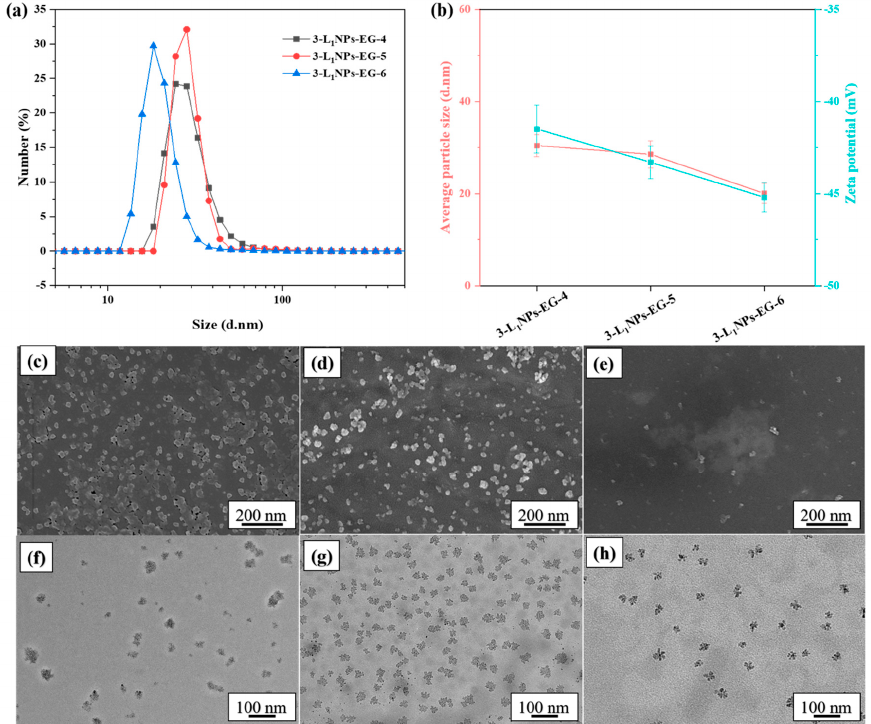
Figure 5. ( a ) Particle size distribution, ( b ) average size and zeta-potential, ( c – e ) SEM and ( f – h ) TEM images of LNPs obtained at different pH conditions. ( c , f ) 3-L 1 NPs-EG-4, ( d , g ) 3-L 1 NPs-EG-5, ( e , h ) 3-L 1 NPs-EG-6.